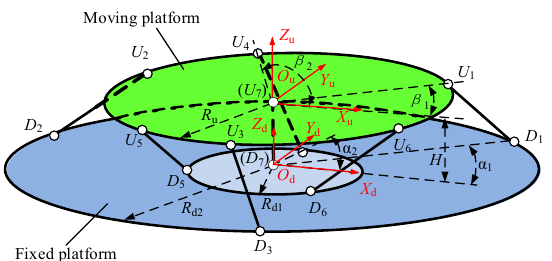
Figure 2 7-SS Passive overconstrained